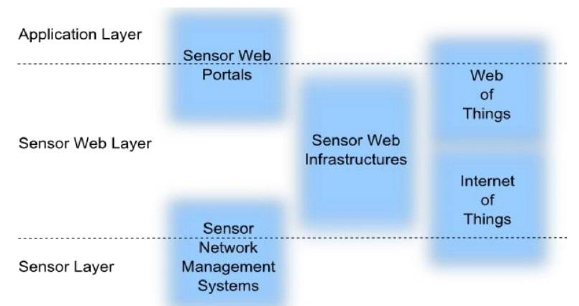
Figure 2. Sensor web layer stack and IoT position in it (Bröring et al.,